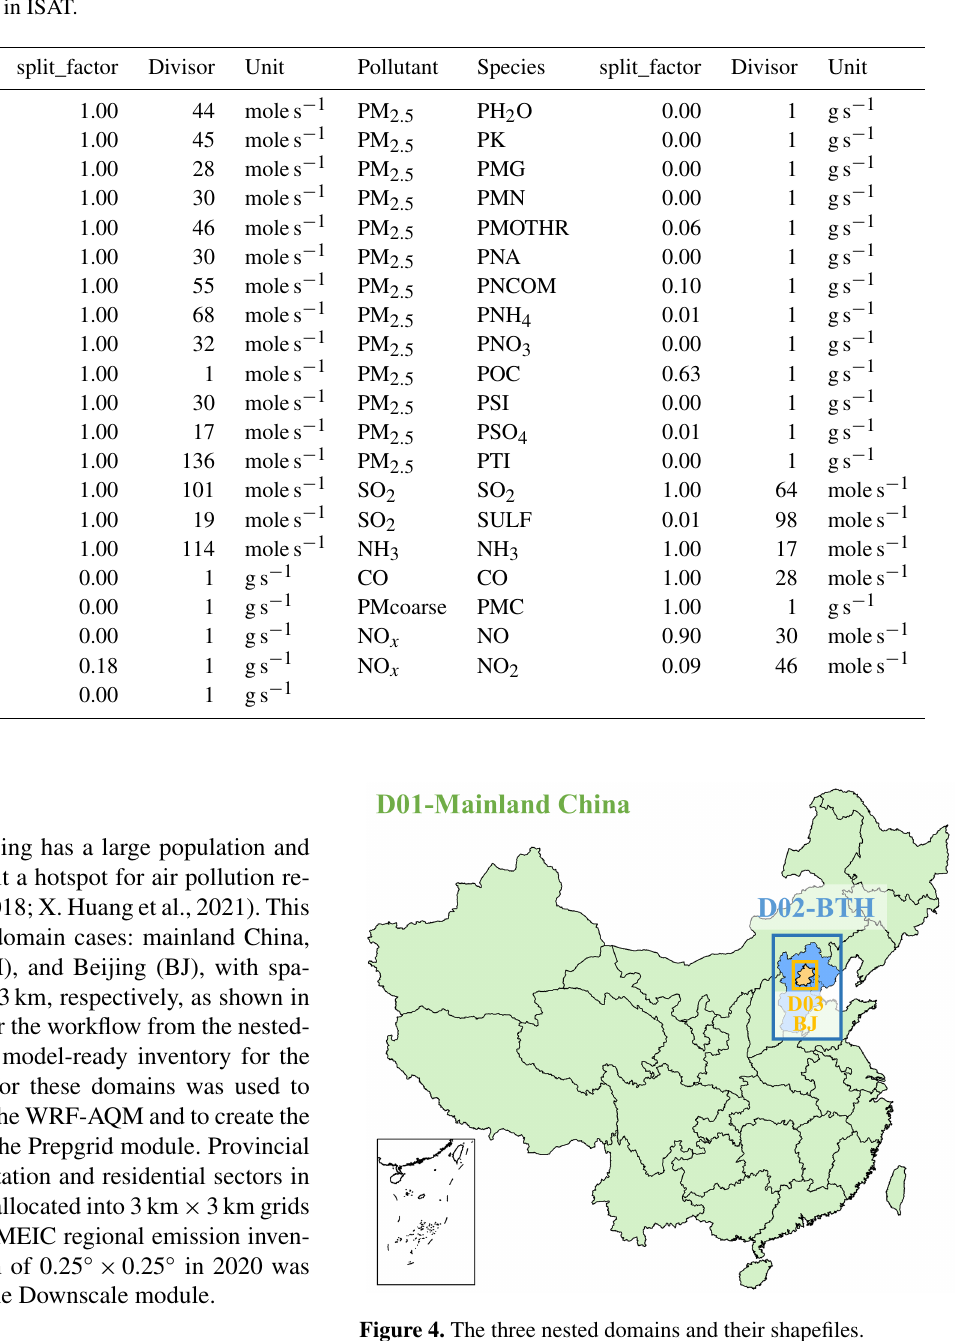
Table 3. Case of speciate profile in ISAT.